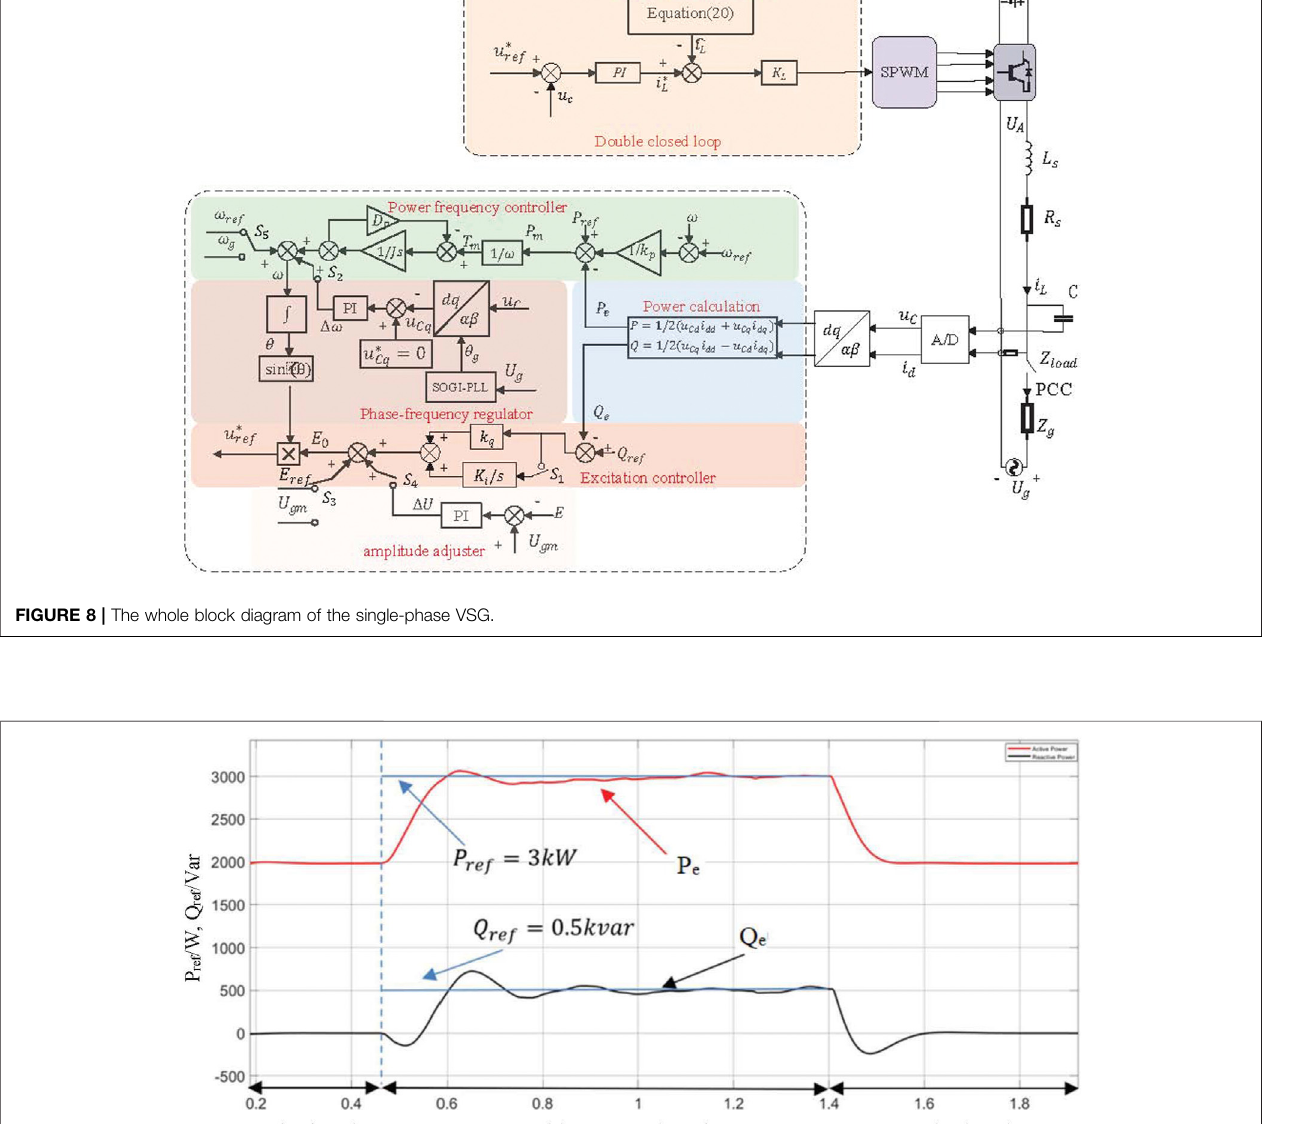
Frontiers in Energy Research |